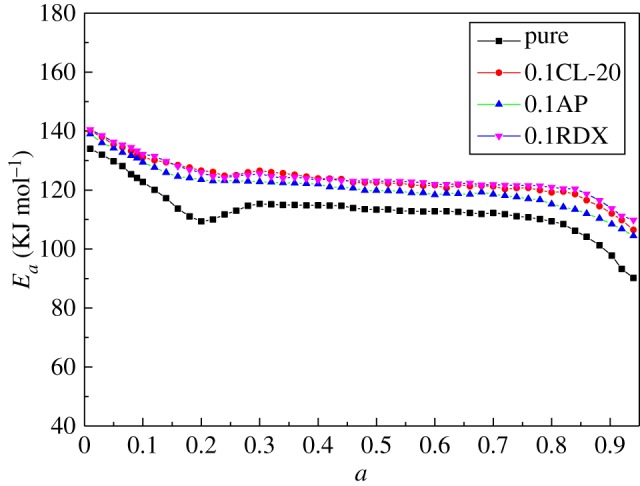
Activation energy Ea as a function of conversion.